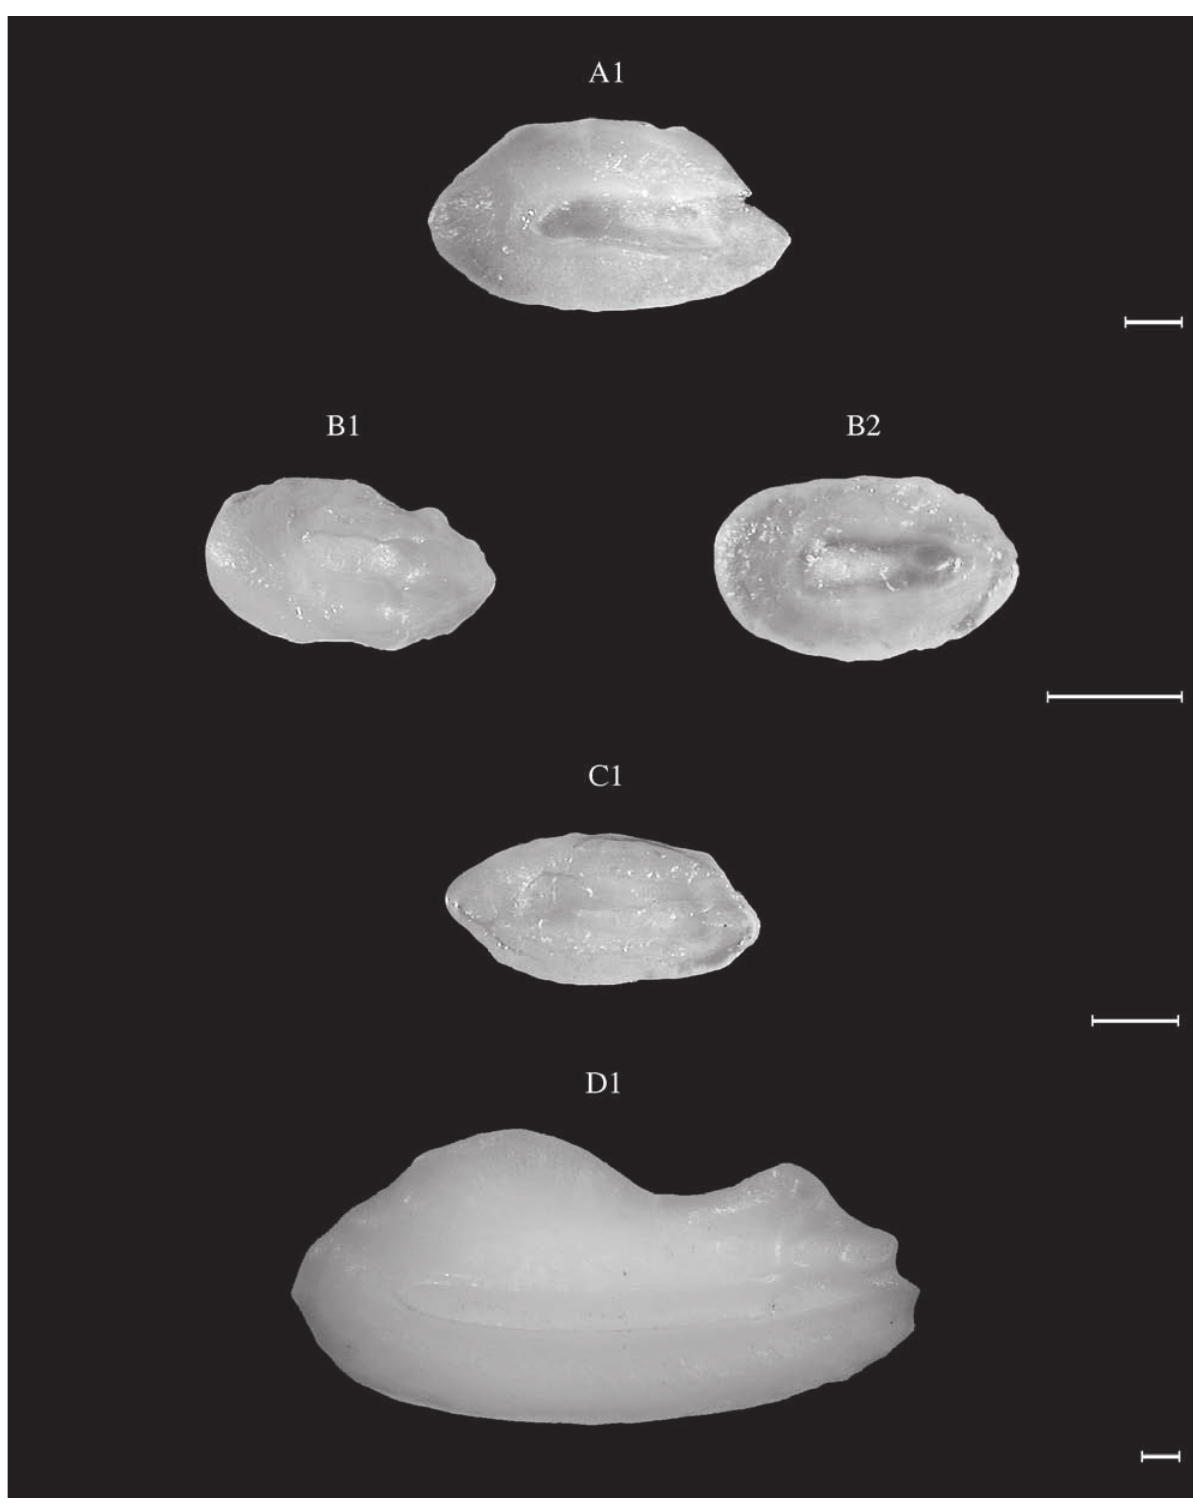
Fig. 13. – Echelus myrus (WM). TL: A1, 62.0 cm. Ophichthus rufus (WM). TL: B1, 35.0 cm; B2, 39.5 cm. Ophisurus serpens (WM). TL: C1, 140.0 cm. Coloconger cadenati (CEA). TL: D1, 63.3 cm. Scale bar = 1